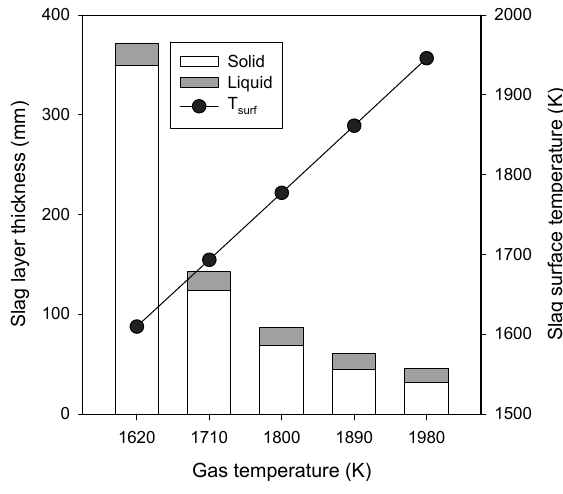
Figure 3. Effects of gas temperature on the slag thicknesses and surface temperature at the slag